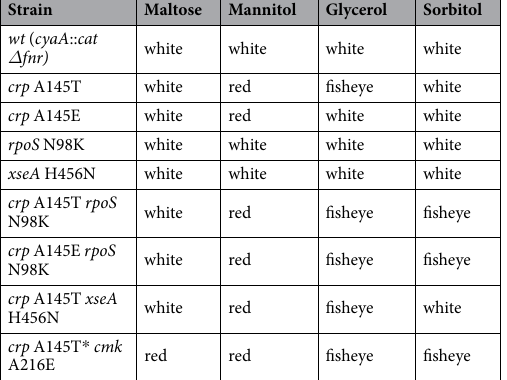
Table 1. Phenotypic characterisation of selected mutants created by recombineering. The phenotypes of the engineered E. coli strains were assayed on MacConkey medium supplemented with maltose, mannitol, glycerol or sorbitol. * The cmk A216E mutant was genome sequenced and contained three additional missense mutations gss A240D, gspC V256I and malT